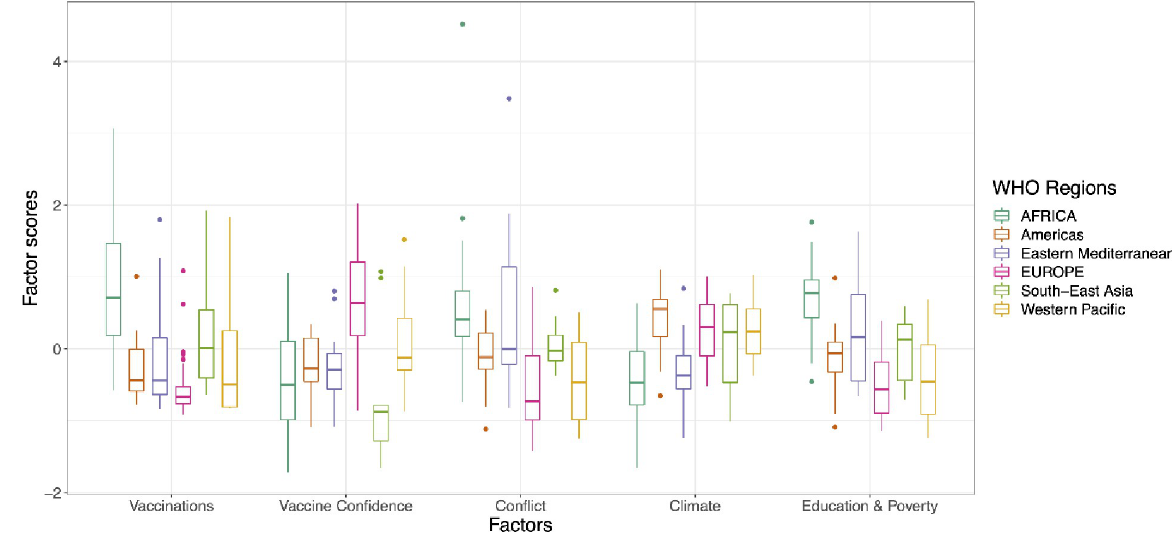
Fig 4. Factor score distributions by WHO